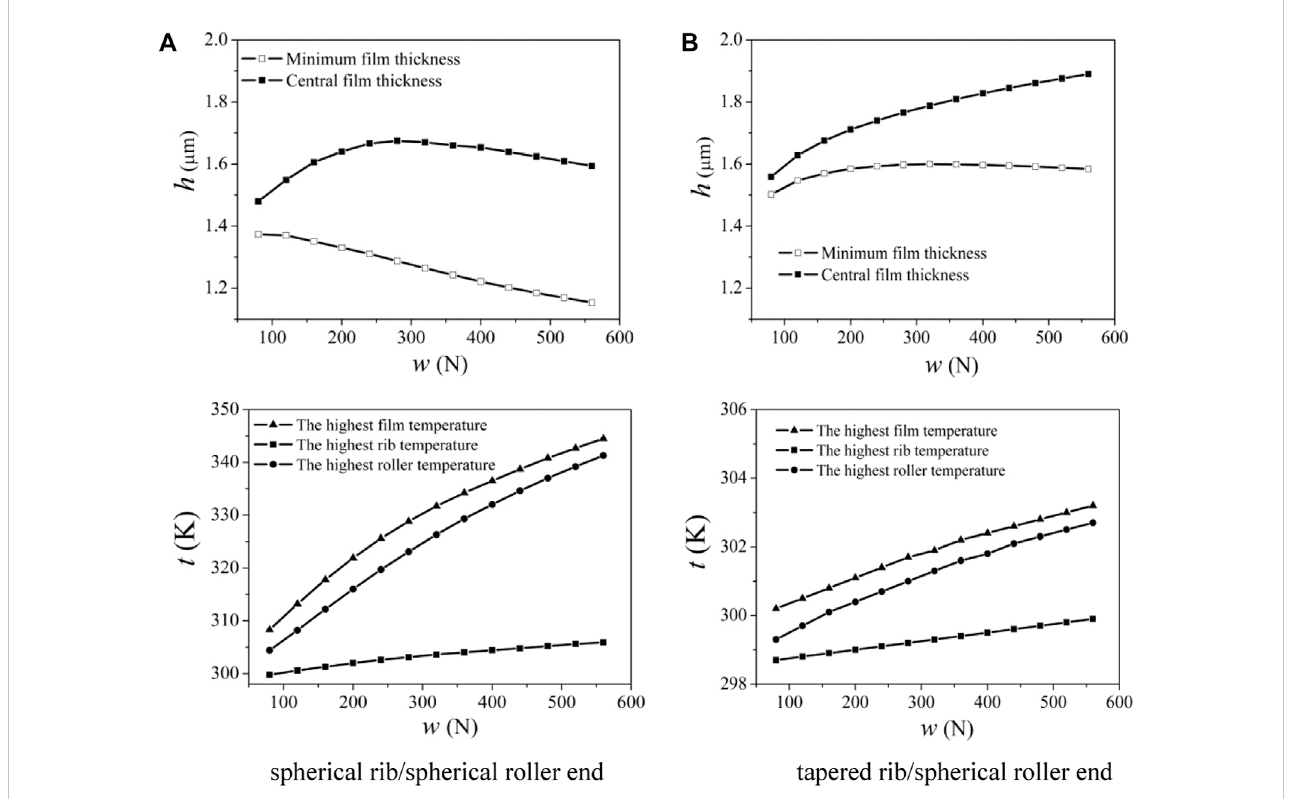
FIGURE 8 Effects of load on fi lm thickness and temperature of two rib structures for R x 2 / R x 1 = 0.7 and n i = 1,000 r/min. (A) Spherical rib/spherical roller end; (B) tapered rib/spherical roller